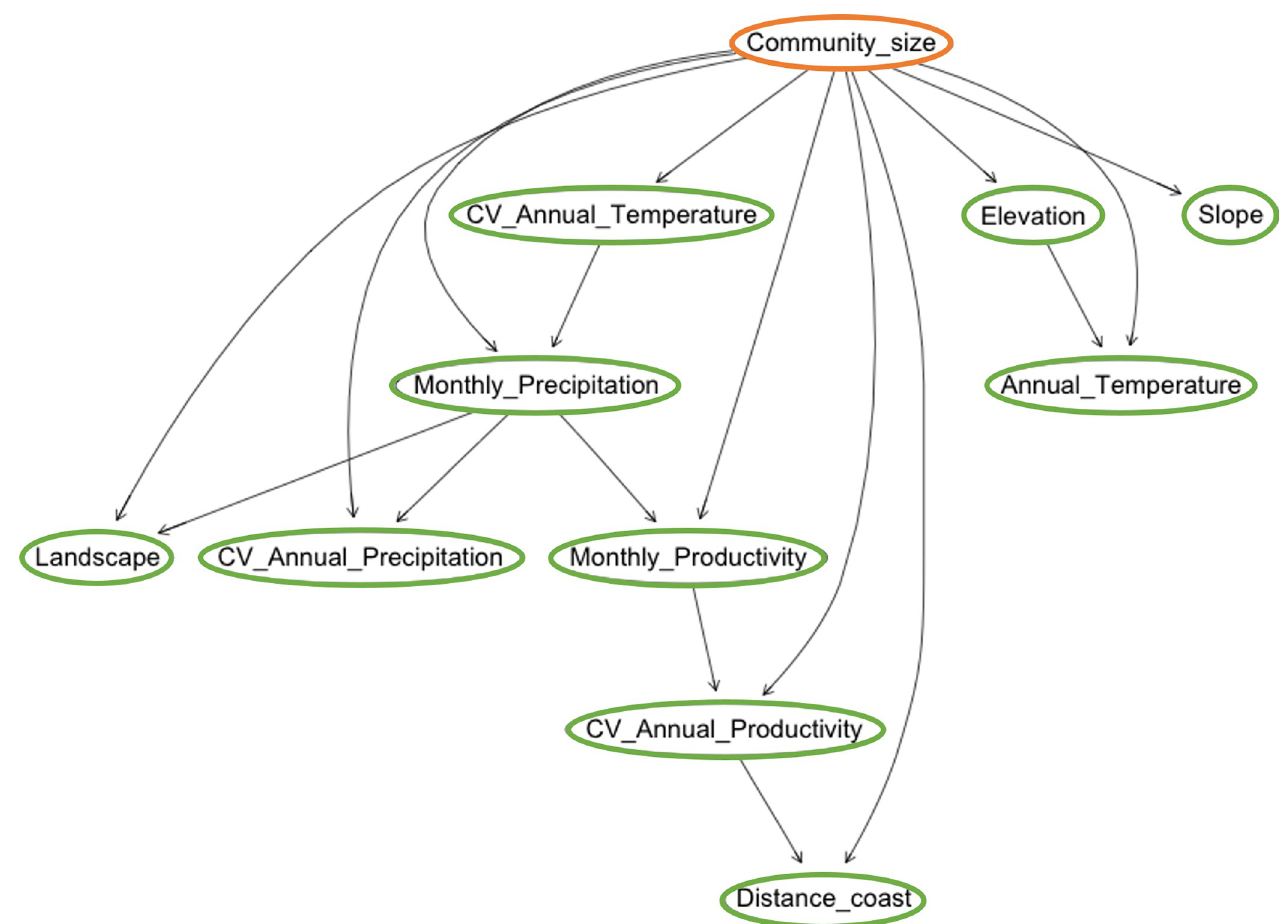
Fig 6. Bayesian Networks of Model A-ANB exploring the relationship between the environment and the social organisation. Dependence between ecological variables (inputs, green) and the size of community (output, orange). The relationship among the amount of inhabitants and the temperature and distance to coast is represented and it can also be observed the high dependence among the different ecological